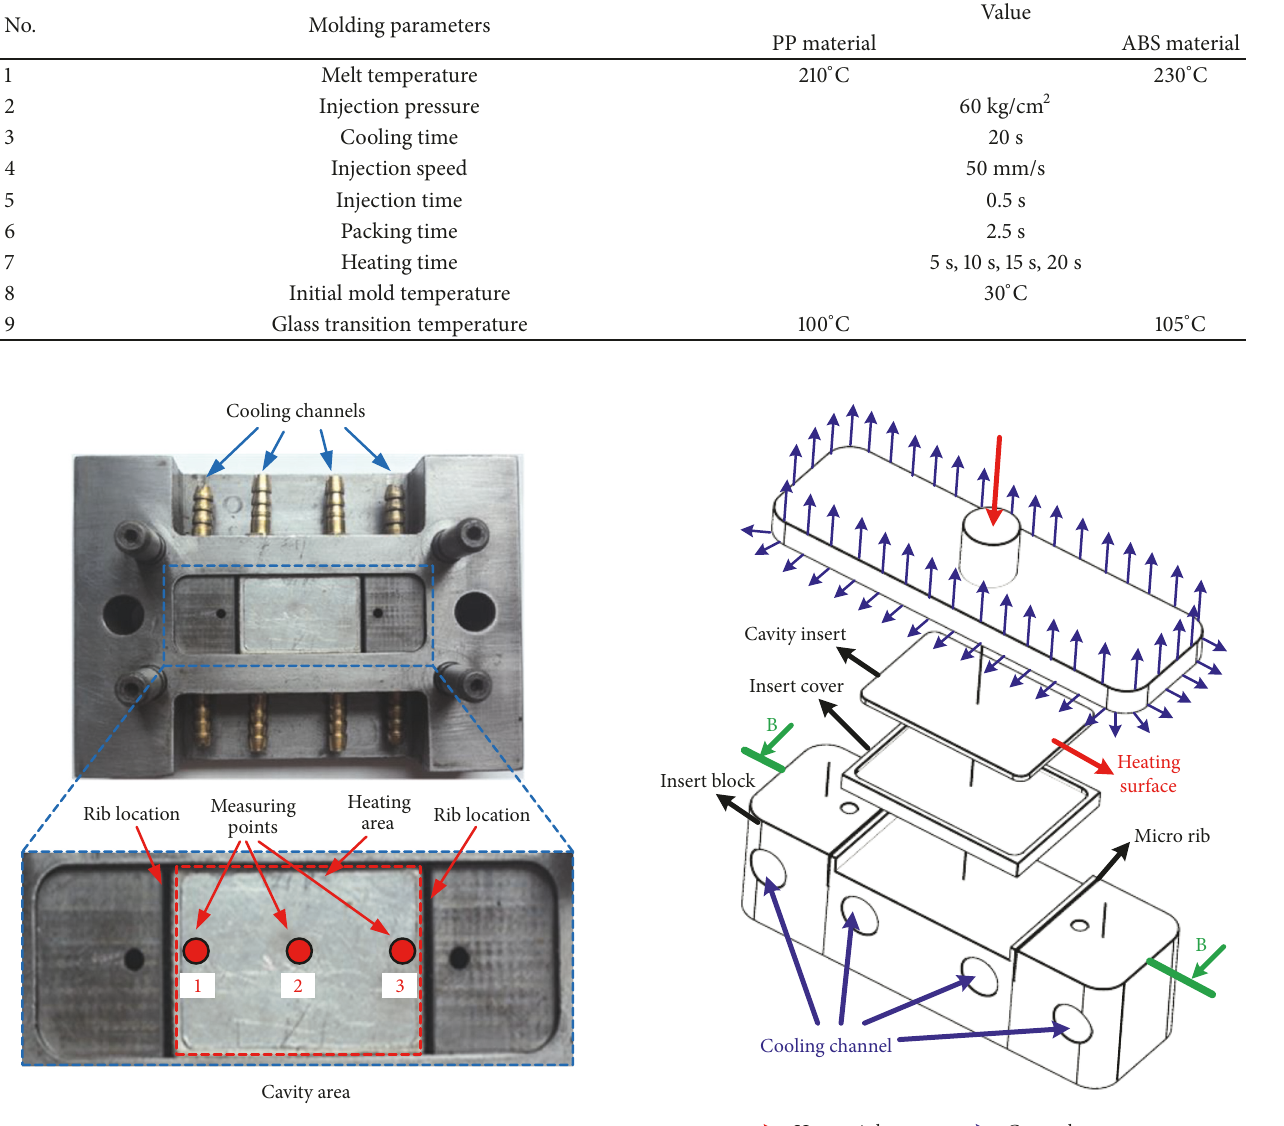
Figure 9: Mold plate of thin rib with the cavity insert.